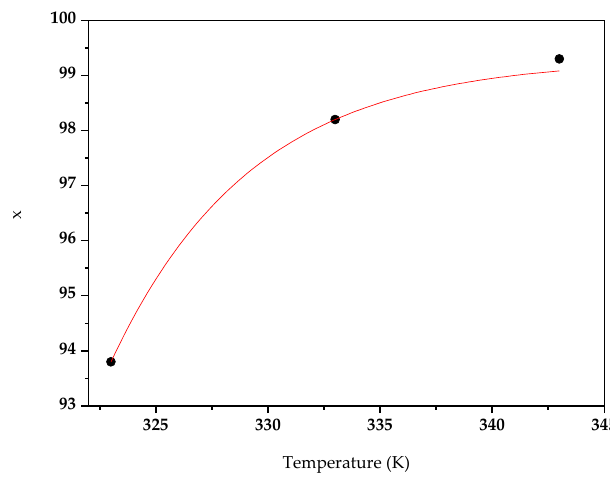
Figure 5. Cellobiose conversion x (%) vs. temperature, K.